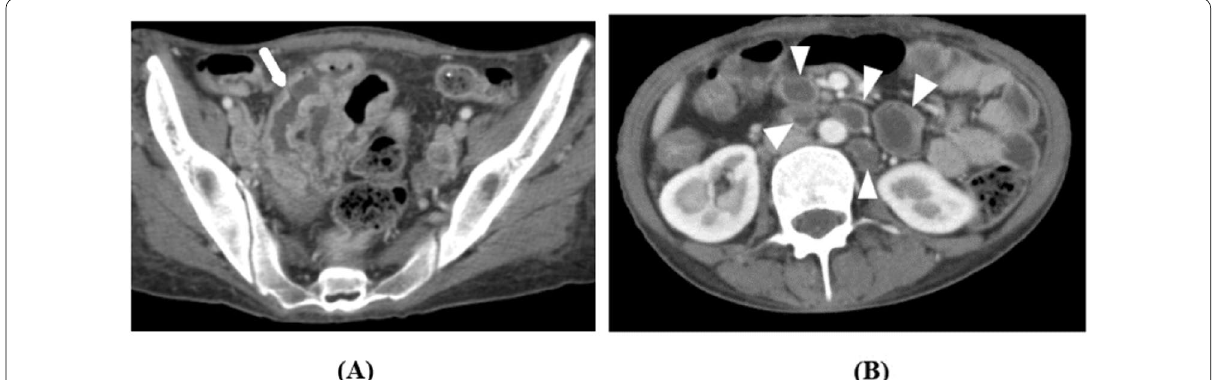
Fig. 3 A 35-year-old female patient with a given history of TB infection complaining of acute abdominal pain, fever anorexia and weight loss. A Axial CT in venous phase shows mild mural thickening with mucosal hyperenhancement (white arrow). B Axial CT in venous phase shows multiple para-aortic and mesenteric necrotic lymph nodes (arrow